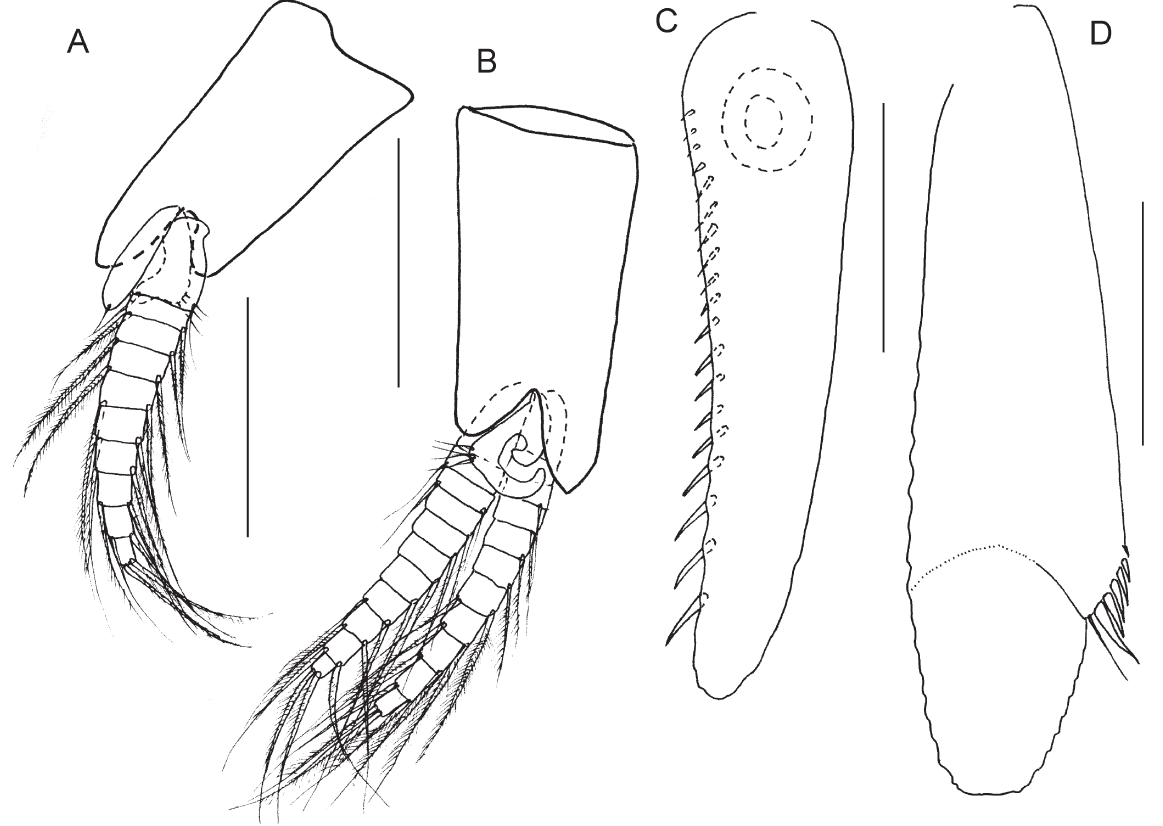
Fig. 20. Siriella occulta sp. nov., holotype, ♂, length 6.5 mm, Arabian Gulf, Saudi Arabia. A . Pleopod 1, posterior view. B . Pleopod 4, posterior view. C . Uropodal endopod, dorsal view. D . Uropodal exopod, dorsal view. Scale bars: 0.25